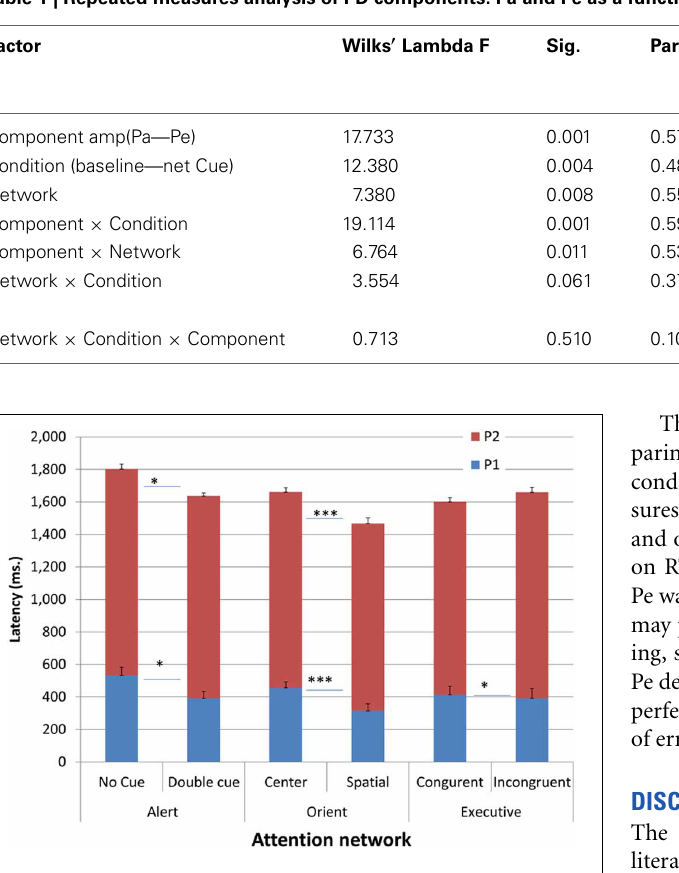
FIGURE 5 | Latencies of Pa and Pe onset as a function of condition and network. ∗ p < 0 . 05, ∗∗∗ p < 0 .